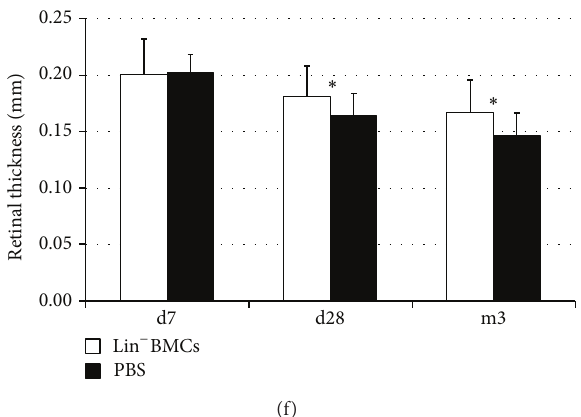
Figure 5: Effects of Lin − BMC transplantation on retinal morphology and the b-wave ERG amplitudes over time. The scotopic (a), mixed rod-cone (b), and photopic (c) response, as well as oscillatory potentials (d), were analyzed repeatedly on the same individual mice during the time of the experiment. The results are presented as the mean ± SD ( 𝑛 = 5 ). Representative in vivo SD-OCT images of the retina on the 7th and 28th day and at the 3rd month after injury showing a considerable improvement in the architecture of the outer and inner photoreceptor segments of the right eyes treated with Lin − BMCs (e). Quantitative comparative analysis of the total retinal thickness of the Lin − BMC-treated retinas compared with the control eyes (f). ∗ 𝑃 < 0.05 for the right eyes treated with Lin − BMCs versus the left eyes injected with PBS ( 𝑛 = 5